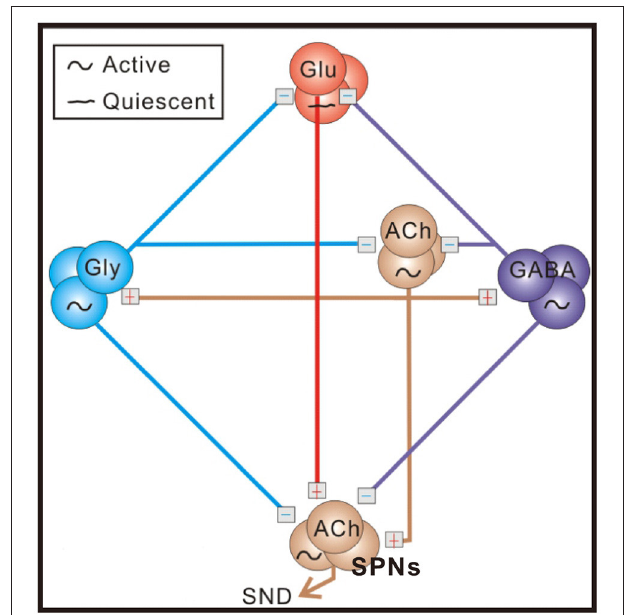
FIGURE 1 | A schematic diagram of the sympathetic-correlated neural circuit in the spinal cord. ACh, GABA, Gly, and Glu label cholinergic, GABAergic, glycinergic, and glutamatergic neurons, respectively. Under control conditions, sympathetic preganglionic neurons (SPNs) generating sympathetic nerve discharges (SND) are activated by cholinergic inputs and inhibited by GABAergic and glycinergic inputs. Blockades of endogenous GABA A and glycine receptor activities enhance excitatory cholinergic inputs and transform tonic SND into bursts by unleashing an ionotropic glutamate receptor-mediated input. Symbols of active and quiescent indicate firing properties under control conditions. See text for references of supporting